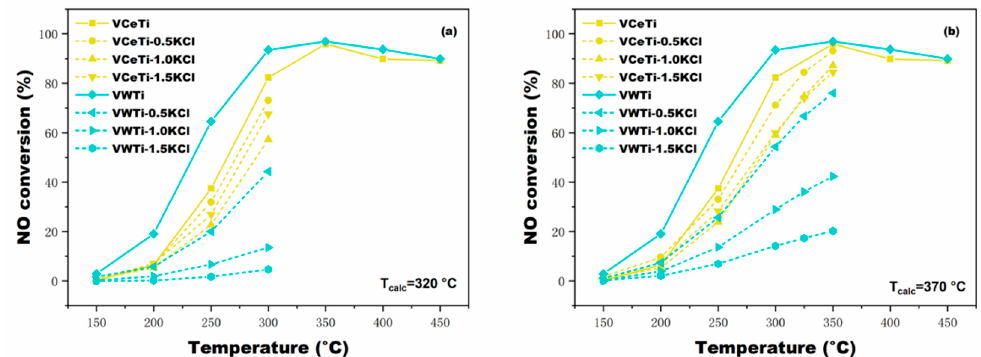
Figure 3. Comparison of activities between V 2 O 5 -WO 3 /TiO 2 and V 2 O 5 -Ce(SO 4 ) 2 /TiO 2 catalyst samples with KCl deposition at different T calc : ( a )320 °C; and ( b )370 °C.